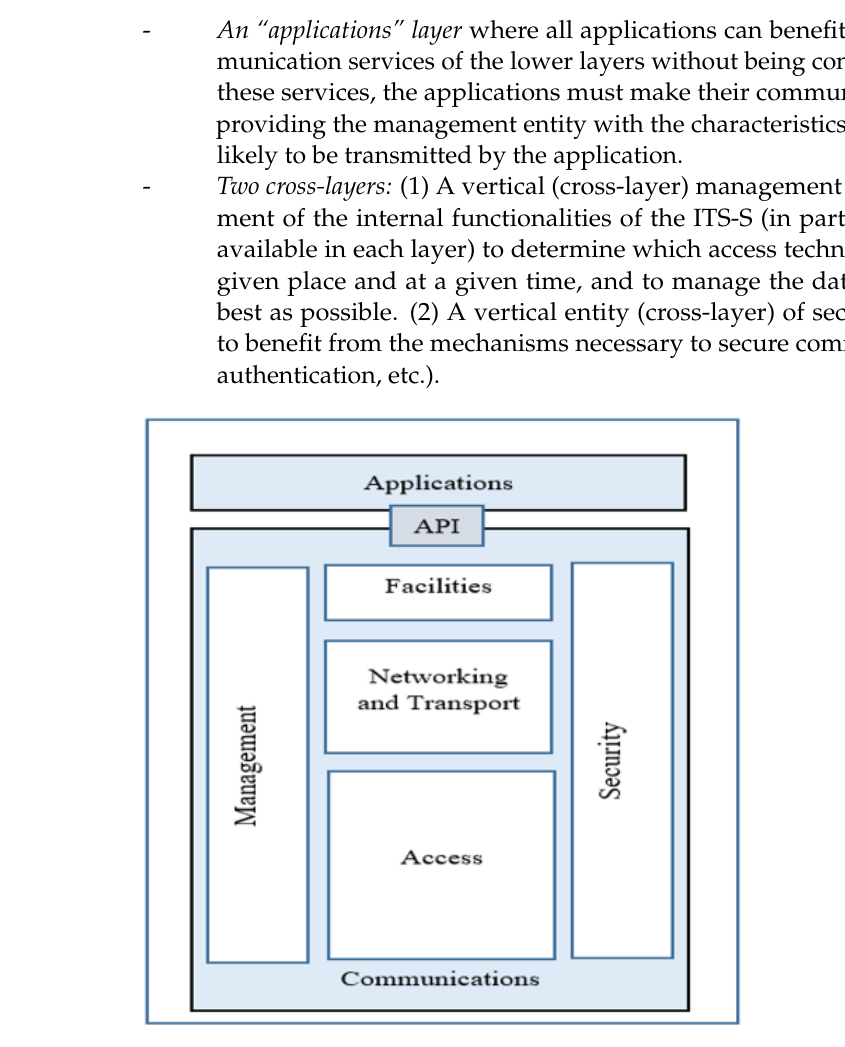
Figure 1. ETSI ITS